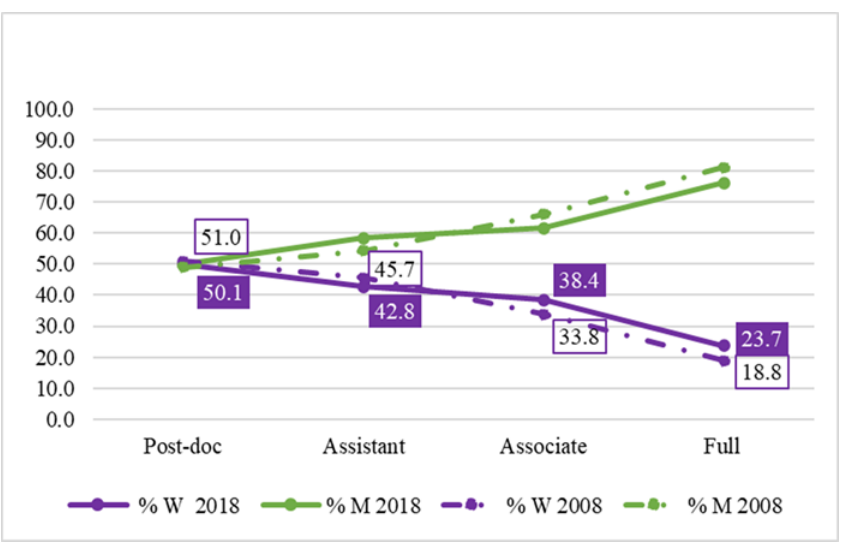
Figure 2: The scissor diagram: Academics by gender, rank and